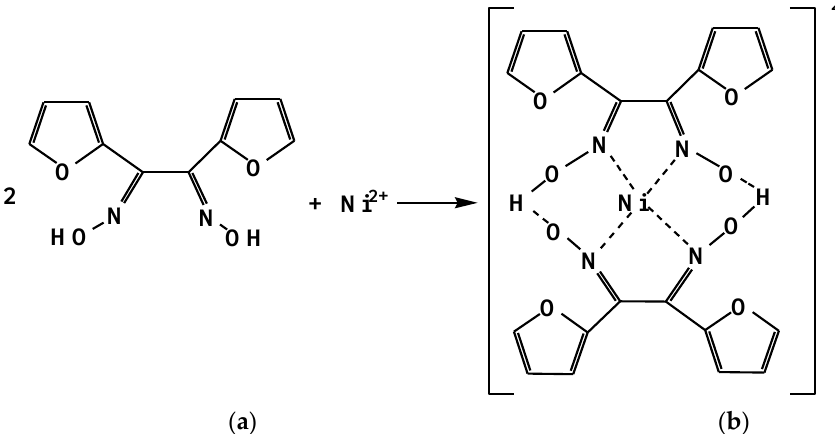
Figure 1. Chemical structures of ( a ) 2,2 furildioxime (FDO), ( b ) Ni 2+ -FDO